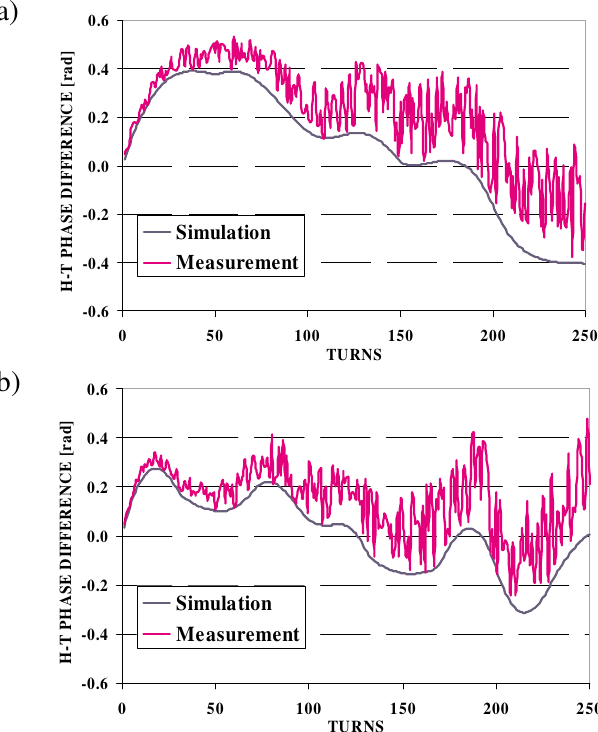
FIG. 24. (Color) Calculated and measured head-tail phase dif- ference for a bunch in the head (a) and a bunch in the tail (b) of the LHC bunch train [6,35].